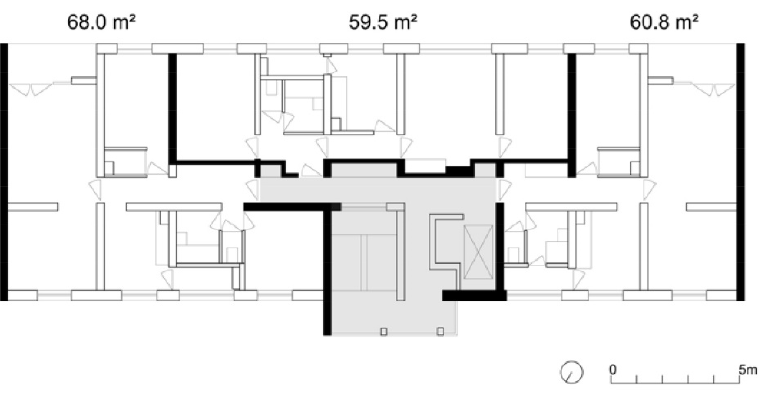
Figure 7. Plan of the part of the H and I buildings in Grand Parc estate before the transformation with information about the useable area of each apartment. Drawing by the author, based on [21].